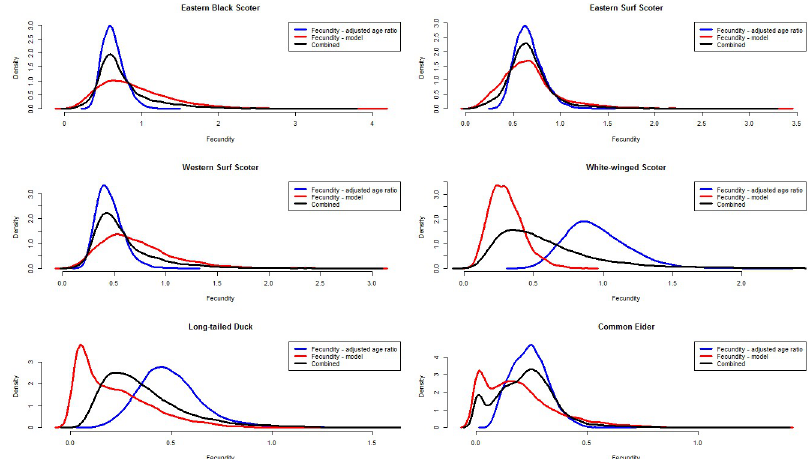
Fig 2. Probability distributions depicting uncertainty in two alternative methods of estimating fecundity for seven populations of North Americansea ducks as well as combined probability distributions that weight both methods